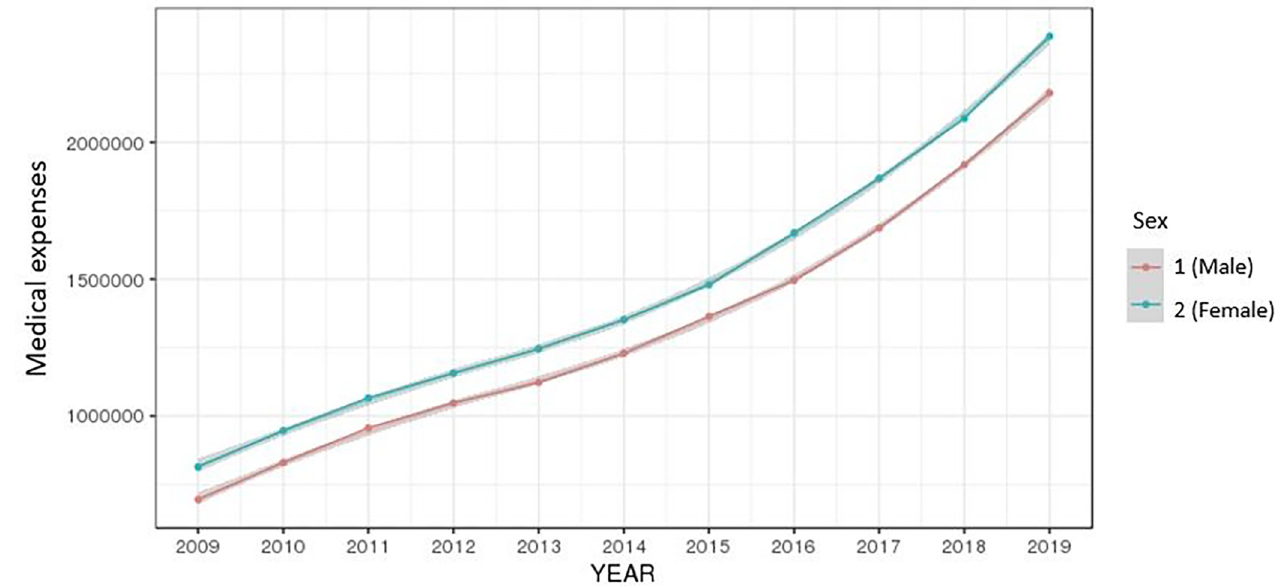
Fig 2. Ten-year trend of medical expenses by